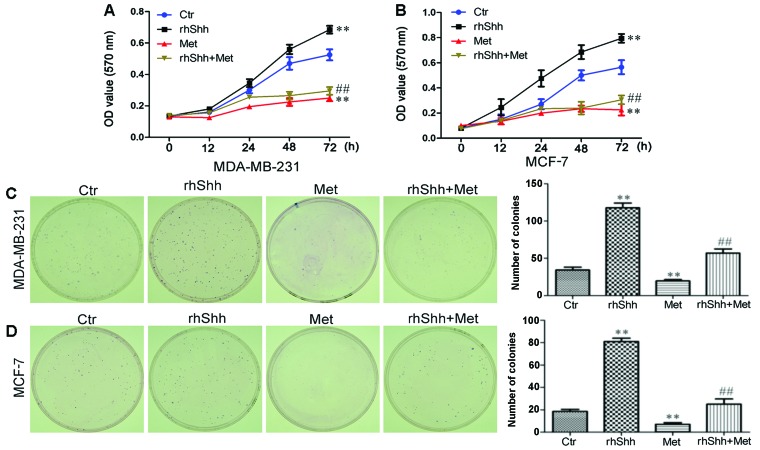
Metformin inhibits the recombinant human Sonic hedgehog (rhShh)-induced proliferation of breast cancer cells. (A and B) MTT assay of MDA-MB-231 and MCF-7 cells was conducted at 0, 12, 24, 48 and 72 h. All data represent the means ± SD of 3 separate experiments performed in triplicate. **P<0.01 vs. the control (Ctr) group, ##P<0.01 vs. the rhShh group. (C and D) Colony formation assays of MDA-MB-231 and MCF-7 cells. The number of colonies was counted under a microscope. **P<0.01 vs. the Ctr group; ##P<0.01 vs. the rhShh group.